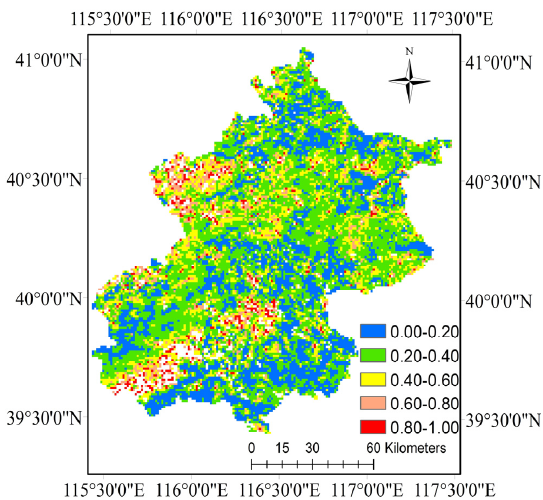
Figure 6. The aerosol optical depth spatial distribution over Beijing. The inversion image was acquired on 7 January 2016, and the reference image (the clear day) was acquired on 5 January 2016. In this inversion progress, d is set to 20. τ ( t 1 ) is assumed to 0.2.